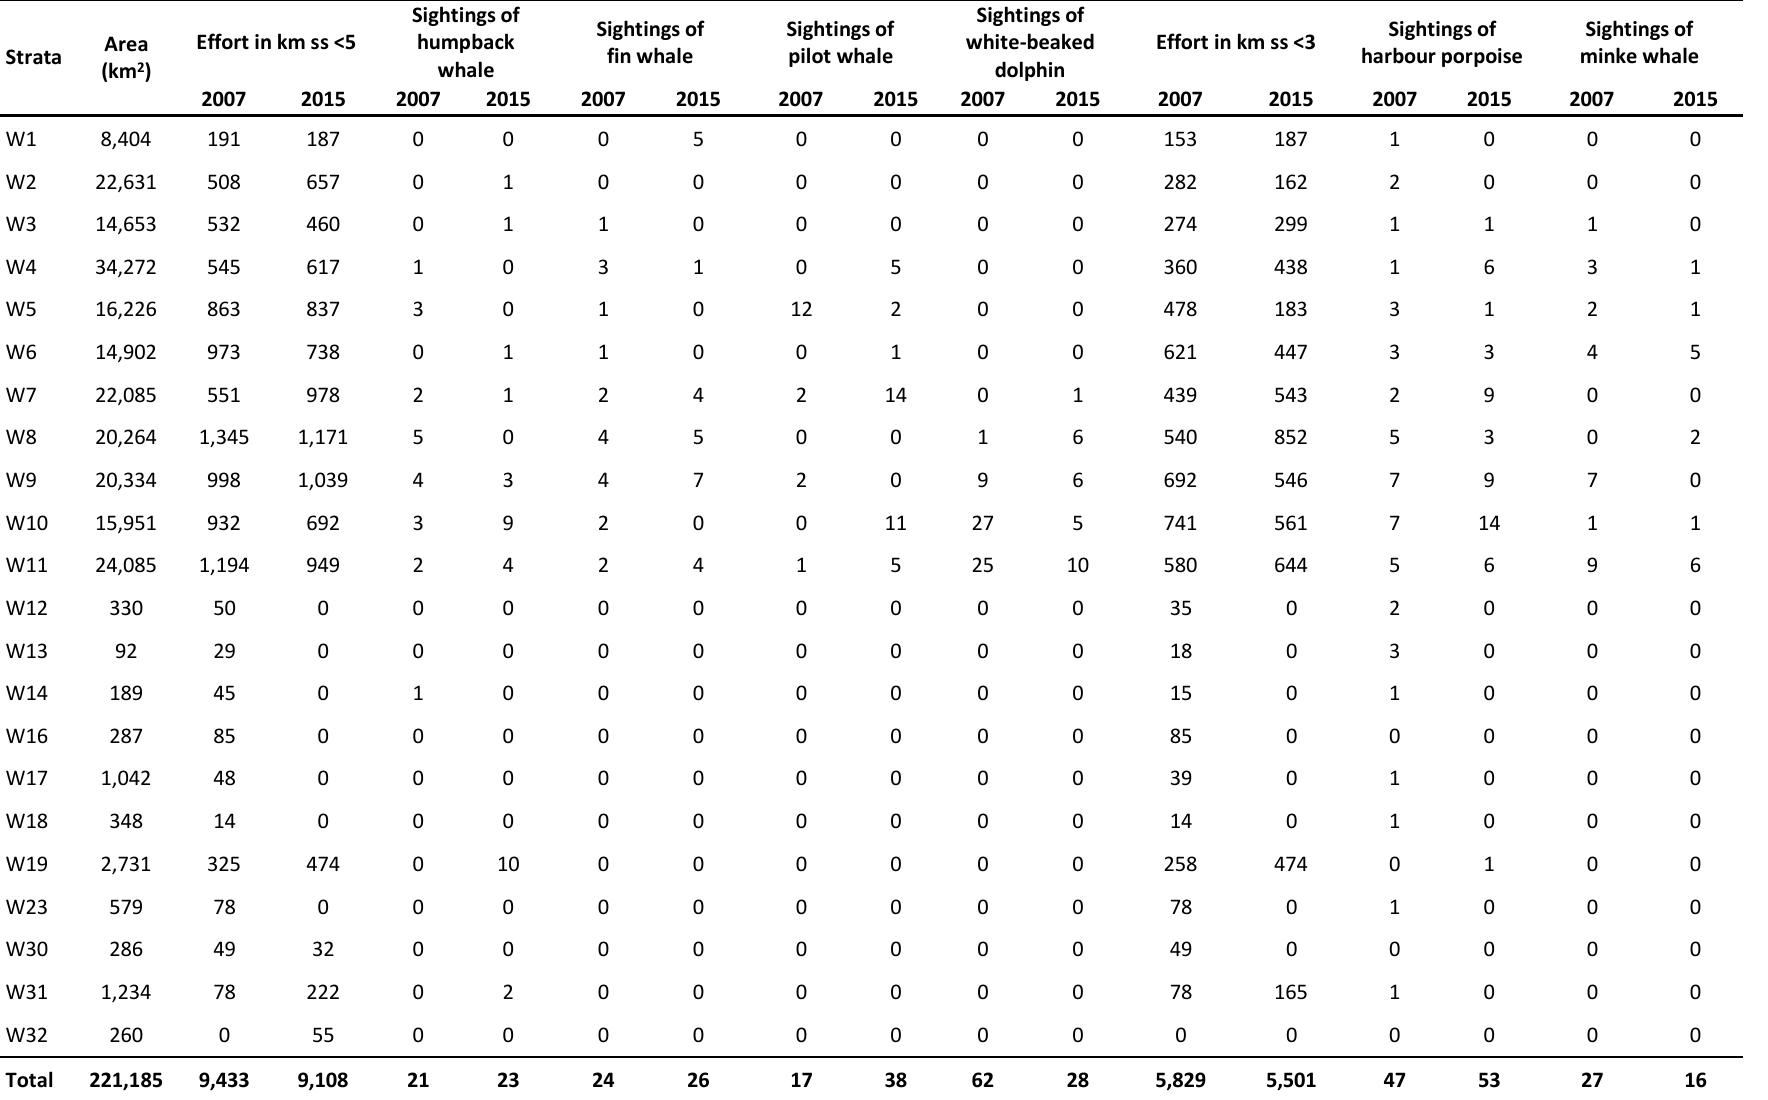
Table 2. Effort in Beaufort sea state (ss) <5 and <3 and number of sightings of humpback whales, fin whales, pilot whales, white-beaked dolphins, harbour porpoises and minke whales in West Greenland in 2007 and 2015.